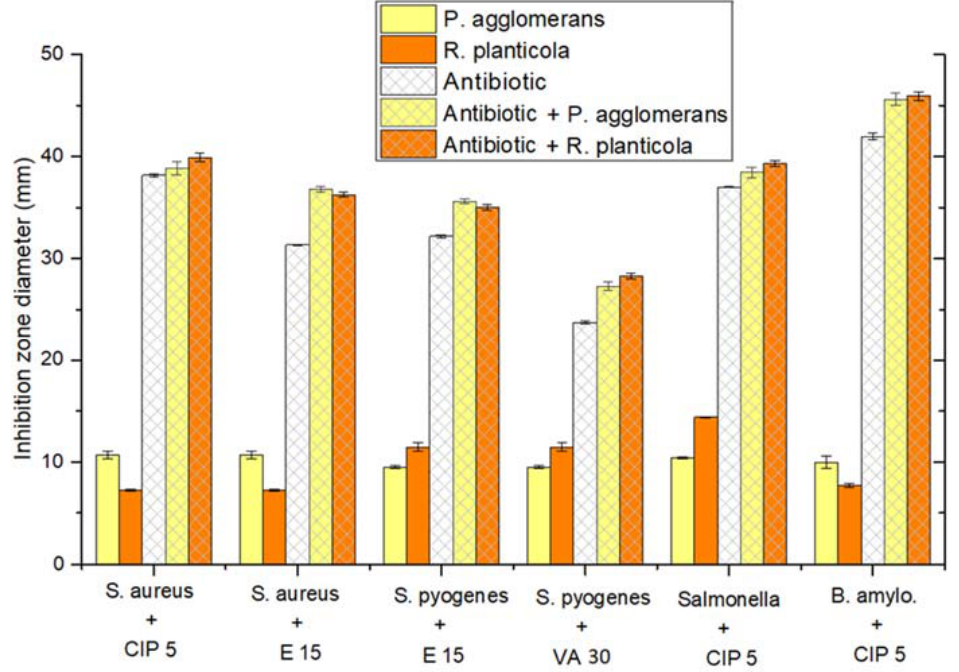
Figure 6. Diameter of inhibition zones for the bacterial strains tested with Ag/AgCl NPs disks, antibiotic disks, and the effect of synergism between AgCl NPs + antibiotics. CIP: ciprofloxacin; E: erythromycin; VA: vancomycin.